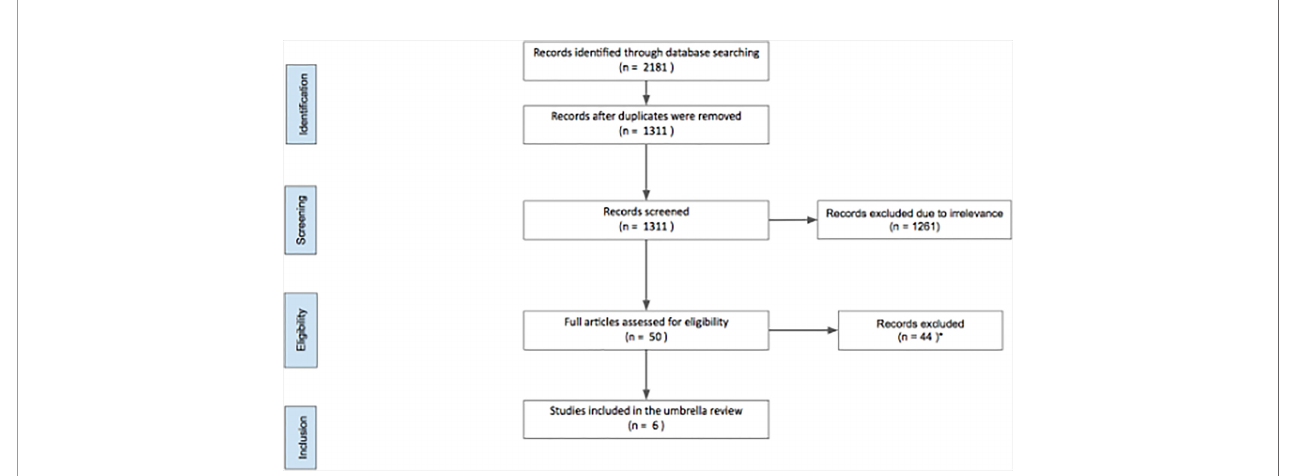
FIGURE 1 | Search fl owchart. *A list of excluded studies is provided in Appendix 1 (List of excluded articles